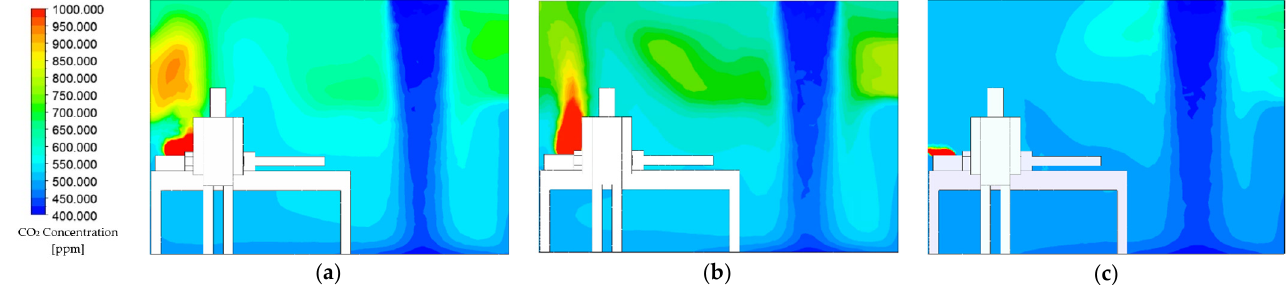
Figure 4. Airflow distribution pattern at 480 s: ( a ) case 1 (existing model); ( b ) case 2; ( c ) case 3.